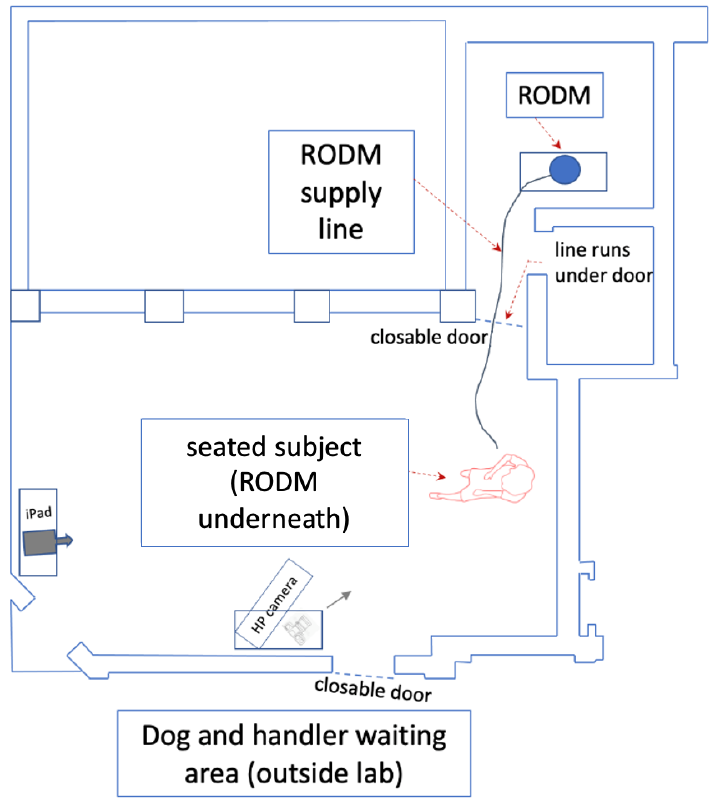
Figure 1. An overview of the test room used and arrangement for the RODM test. The test room measured 10.5 m × 8 m × 4 m.